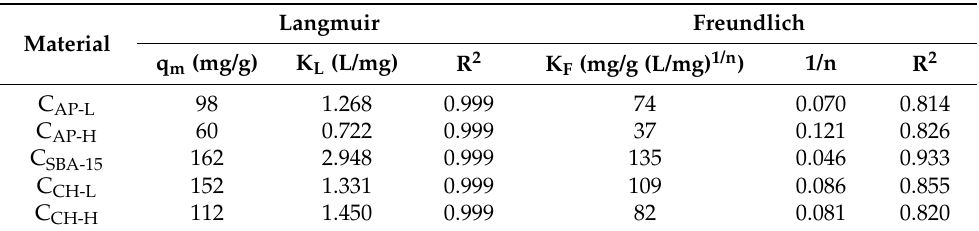
Table 3. The parameters of Langmuir and Freundlich isotherm models fitted to equilibrium data of losartan adsorption on the surface of functionalized mesoporous carbon materials. Langmuir Material